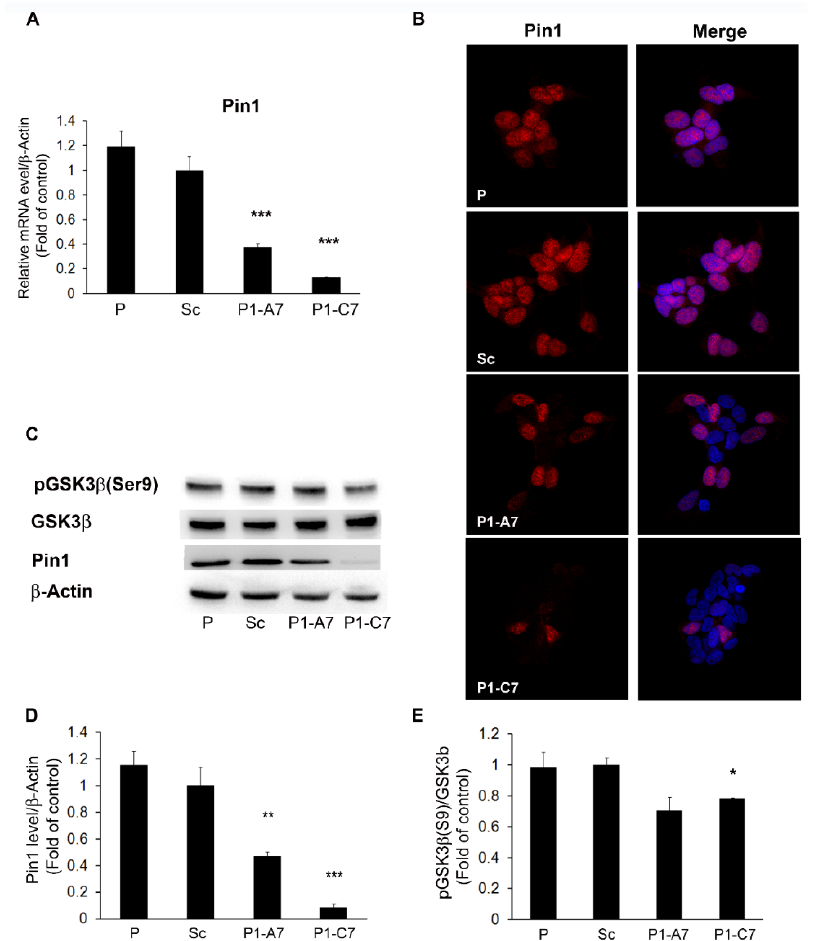
Figure 1. In vitro model of engineered neuroblastoma cells: SH-SY5Y as parental cells (P), Scramble (Sc) and silenced Pin1 clones (P1-A7 and P1-C7). ( A ) Quantitative evaluation of Pin1 mRNA expression level by qPCR. ( B ) Representative fluorescence images of Pin1 in P, Sc and Pin1 KD clones. Red: Anti-Pin1; nuclei are counterstained with Hoechst 33342 (blue color) and combined images are shown. Magnification Images 60×. ( C ) Representative western blots of Pin1, pGSK3β(S9) and GSK3β expression. Lane 1: Parental cells SH-SY5Y, not transfected; lane 2: SH/Scramble cells as negative control for silencing; lane 3: Stable P1-A7 silenced clone; lane 4: P1-C7 silenced clone. ( D ) Quantitative evaluation of Pin1 protein expression level. ( E ) Expression of pGSK3β(S9) respect to GSK3β. β-Actin expression levels were used as loading reference. The data are representative of three independent experiments and are shown as mean values ± SD. * p < 0.05; ** p < 0.01, *** p < 0.001 vs Scramble clone.